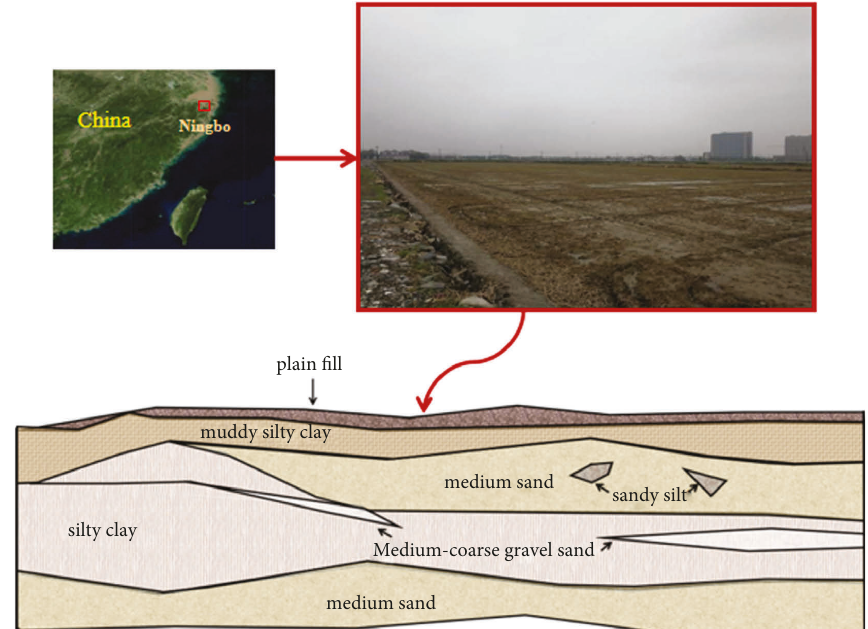
Figure 2: Longitudinal profile of the project.